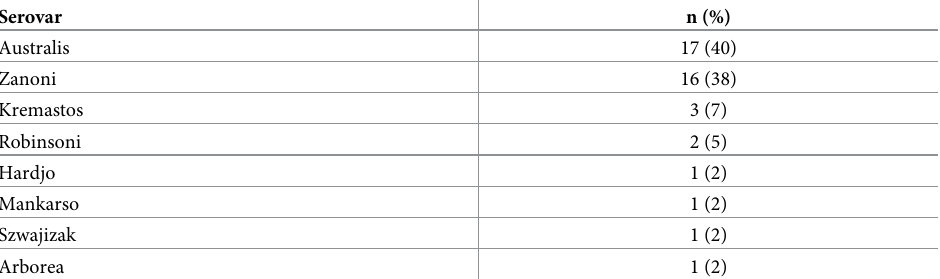
Table 2. Infecting serovar causing leptospirosis requiring ICU care in Far North Queensland, Australia between 1997 and